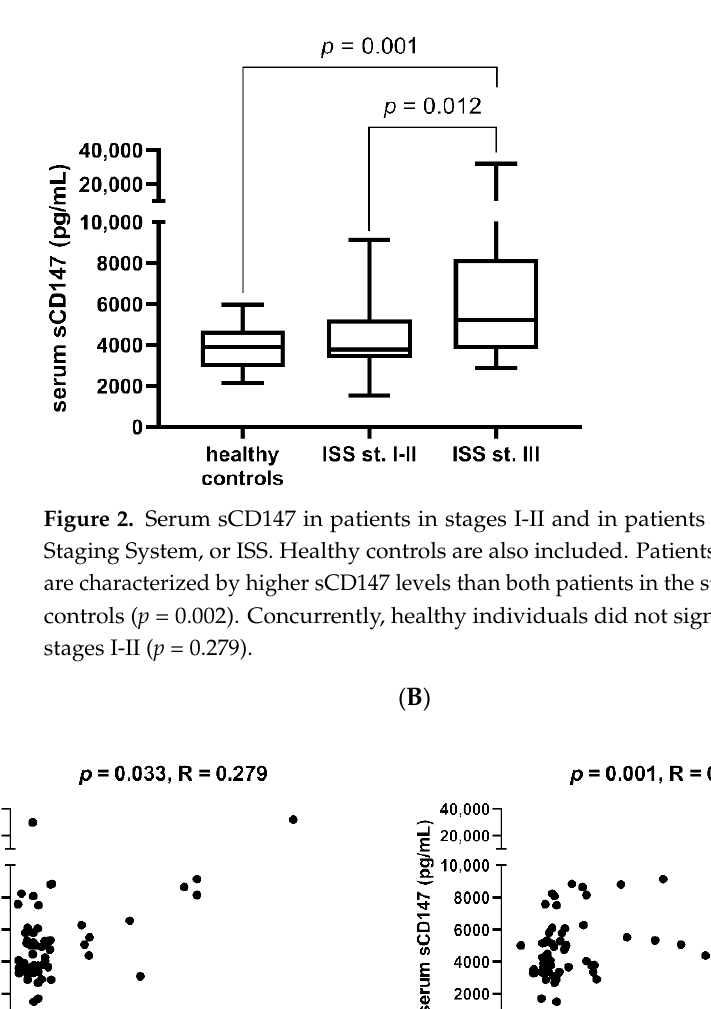
Figure 3. Correlation between serum soluble CD147 and two clinical parameters in MM patients— β 2-microglobulin ( A ) and creatinine ( B ). Serum soluble CD147 is characterized by a weak-moderate correlation with these two parameters.